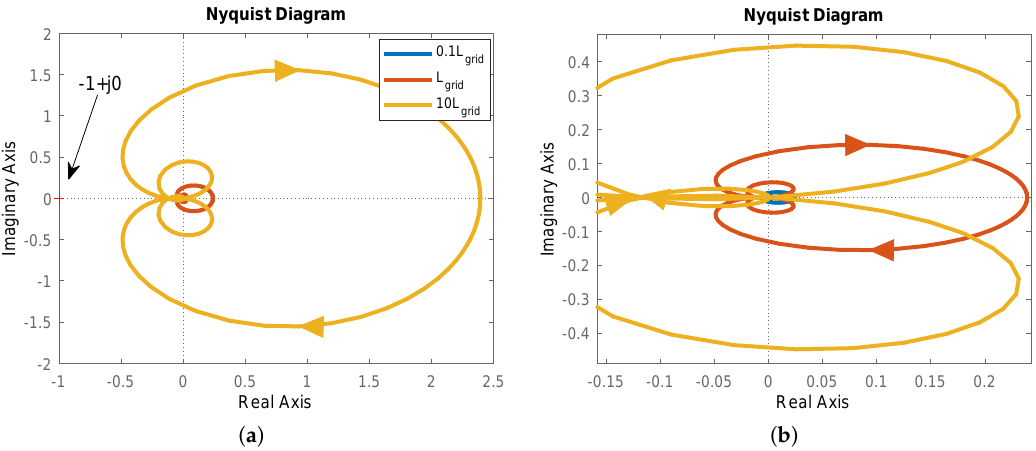
Figure 26. Stability sensitivity to varying SCRs (short circuit ratios); ( a ) main plot; ( b ) zoomed